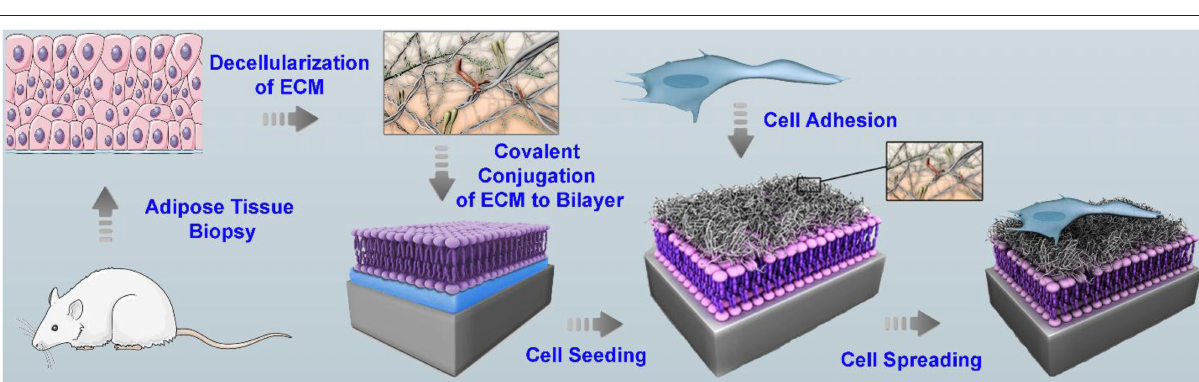
FIGURE 3 | Scheme of the various steps involved in the preparation of SLB functionalized with adipose tissue dECM components for cell culture. The decellularized ECM derived from adipose tissue was solubilized in an acidic condition and was chemically attached via amine coupling chemistry to the surface of a supported bilayer containing lipids with a head group bearing a free carboxylic acid group. Subsequently, cells were cultured and their attachment, spreading, growth, and function were studied. Reprinted with permission from Vafaei et al. (2018). Copyright 2018 American Chemical